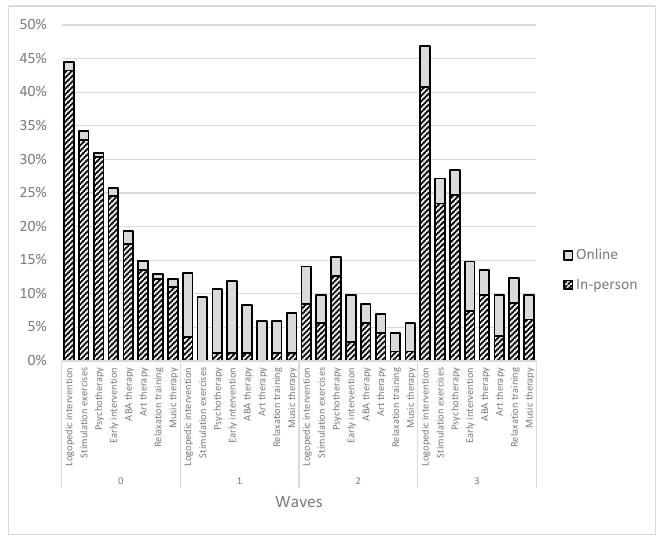
Figure 1. Percentage changes in attendance of various interventions for children with ASD, from pre-pandemic until the third wave.